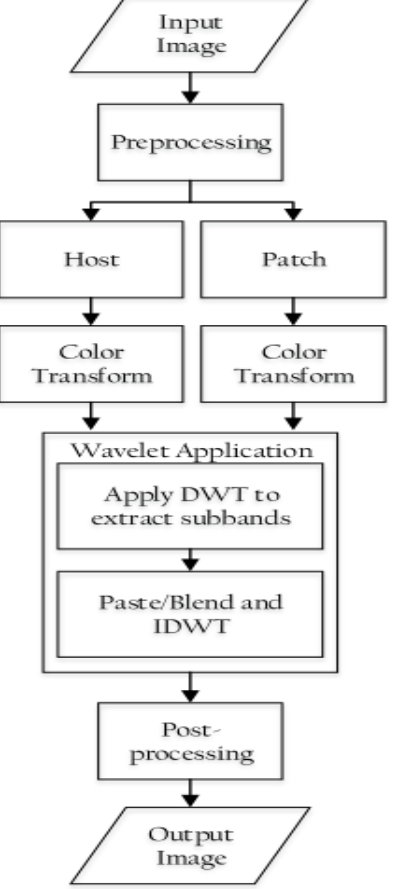
Figure 2. Block diagram representation of frequency-domain